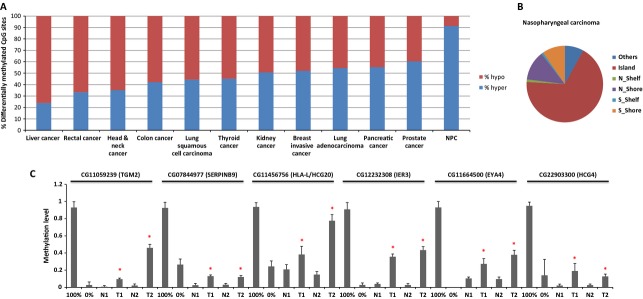
Aberrant methylation in NPC and other types of solid tumors. (A) Percentage of hypermethylated and hypomethylated CpG sites identified by LIMMA analysis with FDR < 0.001 in NPC and other types of solid tumors. hypo: hypomethylated CpG sites, hyper: hypermethylated CpG sites. (B) Categories of the genomic locations of de novo methylated CpG sites in NPC. Island: CpG island, N_Shelf: north shelf region of CGI, N_shore: north shore region of CGI, S_Shelf: south shelf region of CGI, N_Shelf: north shelf region of CGI. (C) Verification of the aberrant methylation of six selected loci identified in NPC by bisulfite pyrosequencing. 100% methylation control; 0% no methylation control; N: normal adjacent tissues, T: NPC tumor tissues. *Methylation level in tumor is significantly higher than matched nontumor tissue examined by Mann–Whitney U-test with P < 0.05. NPC, nasopharyngeal carcinoma; FDR, false discovery rate; CGI, CpG island.